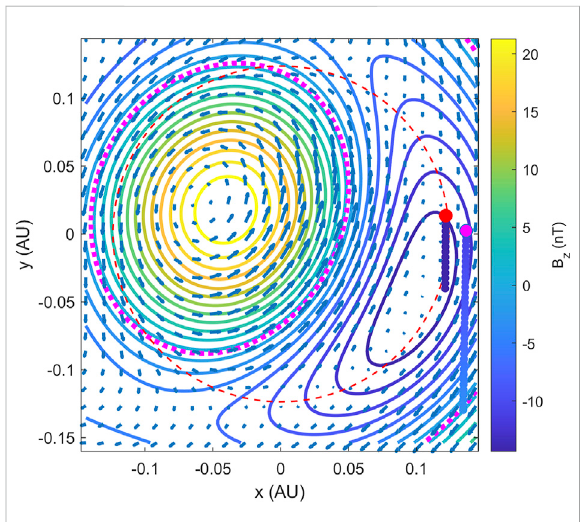
FIGURE 5 One cross section at z =0 plane for the optimal FS model corresponding to Figure 4. The colored contours are the distribution of B z with scales given by the colorbar. The magenta dotted curve marks the boundary where B z =0. The blue arrows show the distribution of the transverse magnetic fi eld on this plane. The red thin dashed curve denotes a circle of radius a =0.12AU.Thetwostraightshortlinesofdots,color-codedbythe corresponding B z values, mark the paths of STA and PSP, with the starting points colored in red and magenta, respectively.